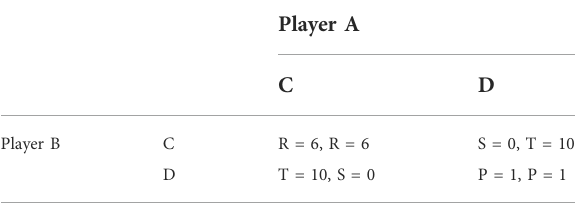
TABLE 2 Payoff matrix for 2-player Prisoner ’ s